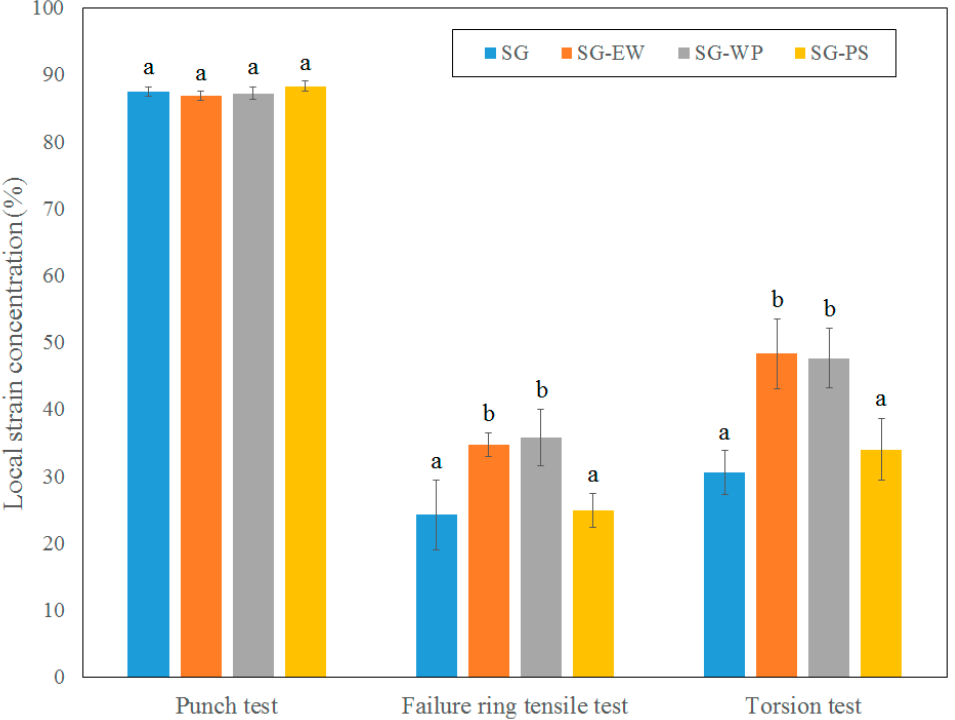
Figure 5. Local strain concentrations for the penetration test, failure ring tensile test, and torsion test. Different letters in each test method indicate that values are significantly different ( p < 0.05).